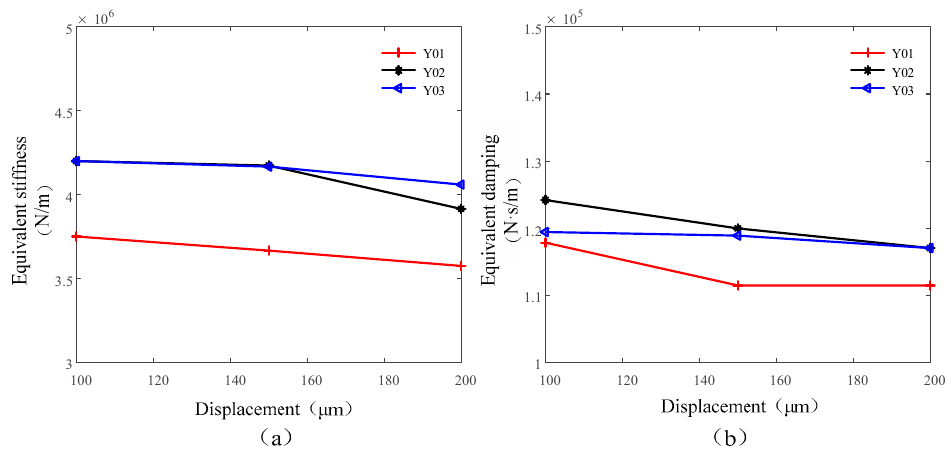
Figure 11. Dynamic parameters of specimens Y01~03 vary with displacement at 1 Hz: ( a ) equivalent